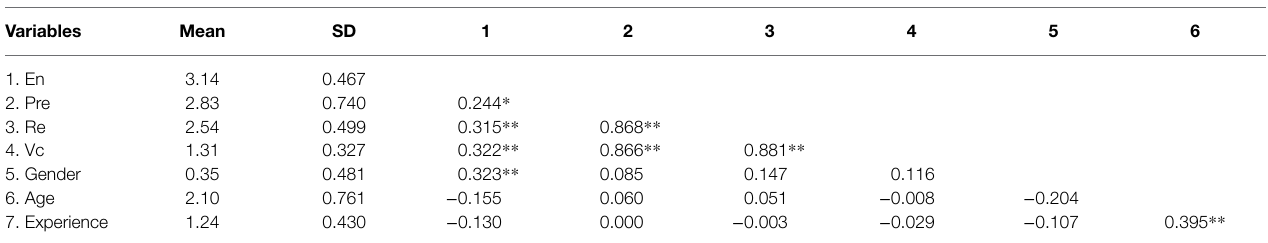
TABLE 4 | Means, standard deviations, and correlations for all variables.